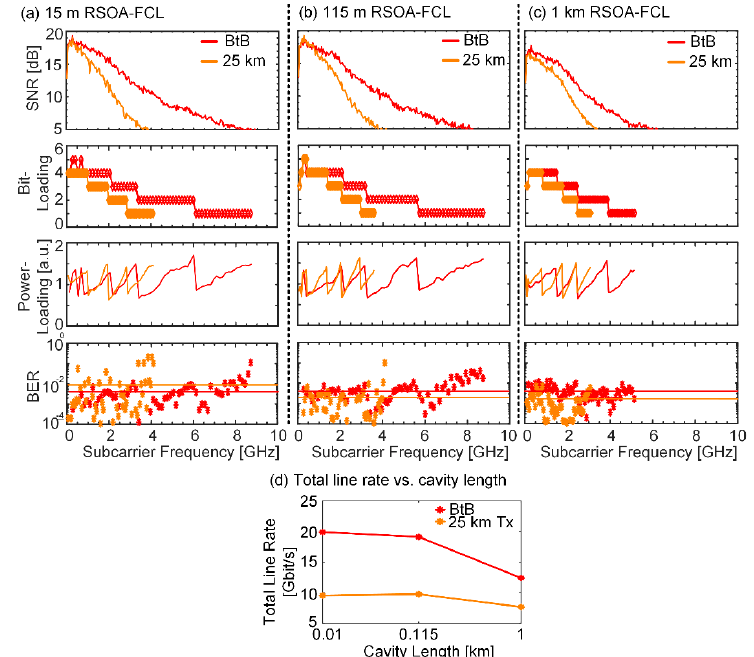
Figure 10. Measured SNR, bit- and power-loading pattern, and bit error ratio (BER) versus sub-carrier frequencies and the achieved total line rate for different RSOA-FCL cavity lengths: Plots ( a – c ) show the results for 15, 115 m and 1 km long cavities, respectively. The red and orange colors indicate BtB (back-to-back) and 25 km NZDSF transmission measurements. In all cases, the overall BER (solid lines in the BER plots) are kept below the FEC limit of 9.29 × 10 − 3 [53]; ( d ) Plots the measured total line rate for 15, 115 m and 1 km long cavities, both for BtB and after 25 km transmission. In a BtB measurement, the RSOA-FCL offers up to 20 Gbit/s line rates. The line-rate is still 10 Gbit/s when transmitting signals over 25